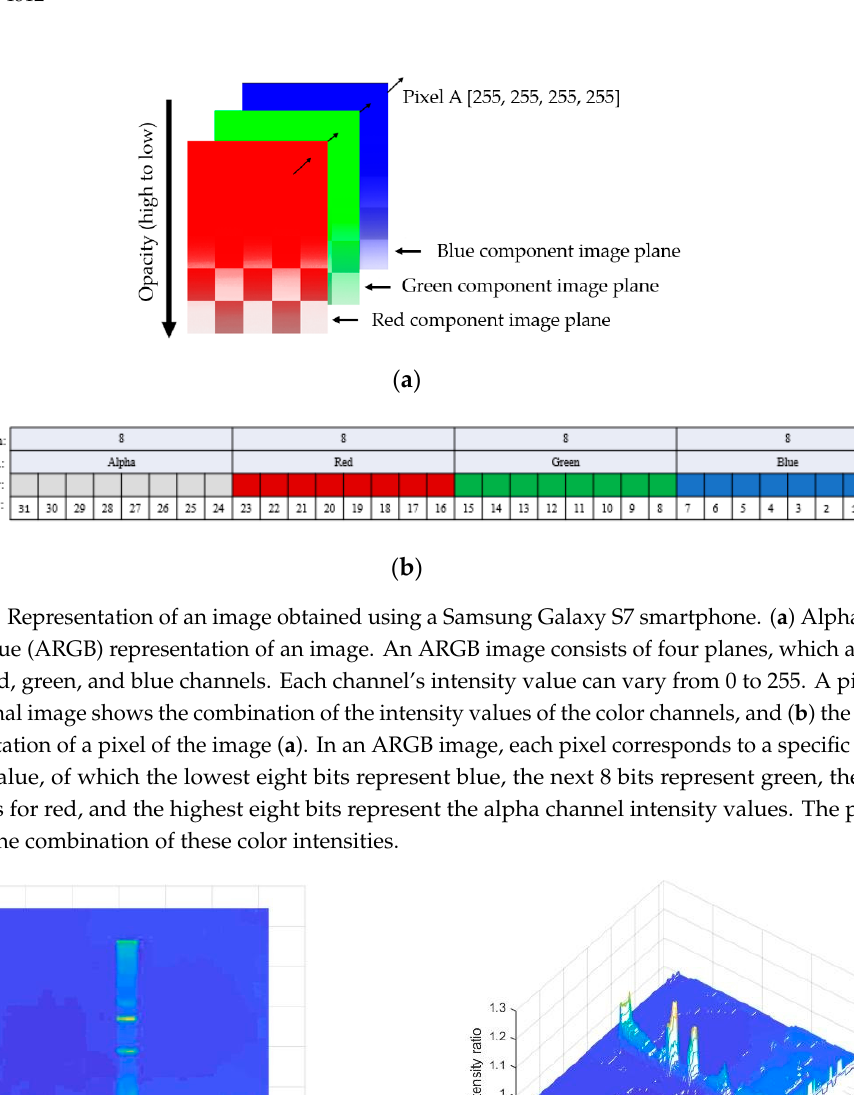
Figure 6. Ratio of red channel to green channel of a sample LFA strip is visualized by ( a ) a 2D surface, and ( b ) a 3D surface. It is clear that the test and control lines had the maximum value that can be used to differentiate them from other regions.